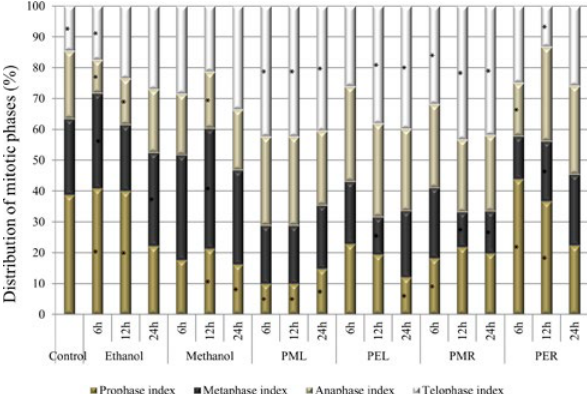
Fig. 3. The influence of the extracts of leaves and rhizomes of Poly- stichum setiferum (Forssk.) Moore ex Woyn. on the mitotic index in meristematic root cells of Allium cepa L. (*the interpretation of the significance of the differences by means of the Tukey test, p<0.05).